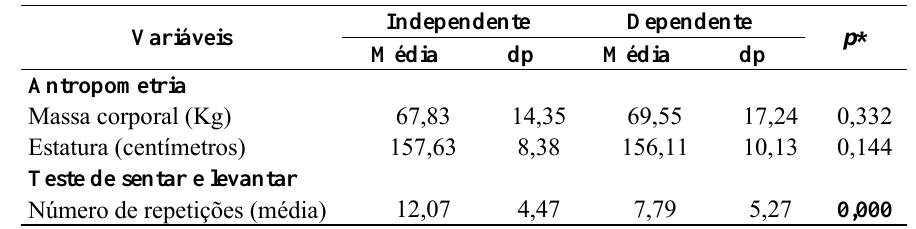
Tabela 2. Distribuição das variáveis antropométricas e número de repetição no teste de sentar em levantar em relação a condição de dependência para realização de atividades básicas da vida diária , Uberaba, MG, Brasil, 2010.